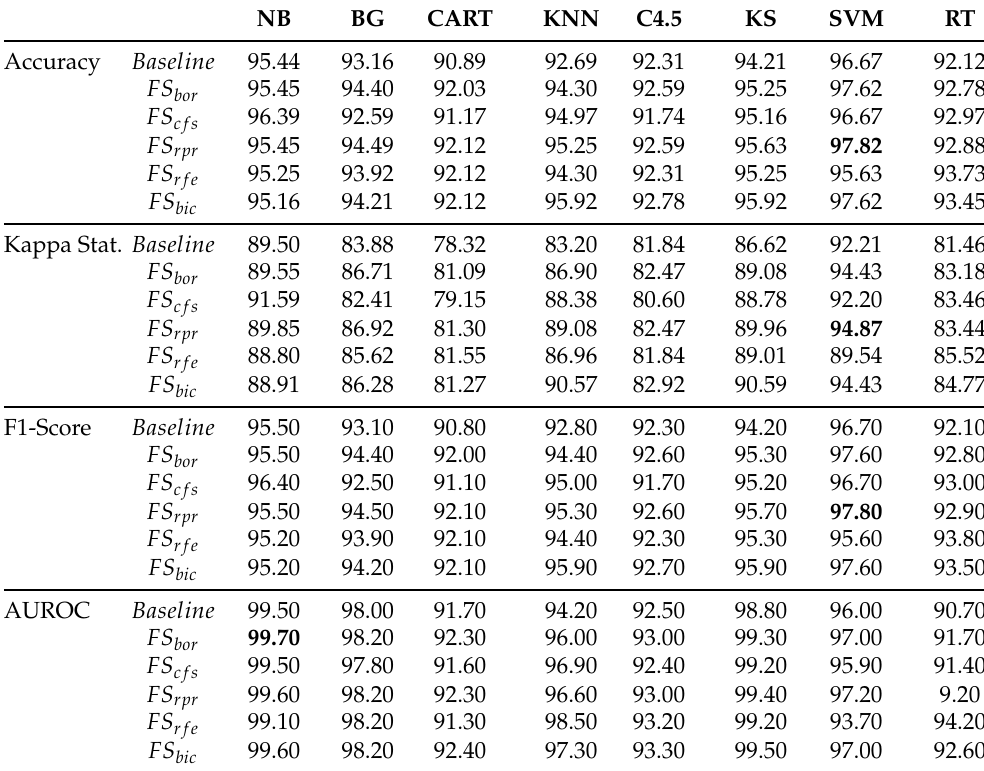
Table 5. Performance analysis of classifiers for baseline and its generated feature subsets of toddlers.